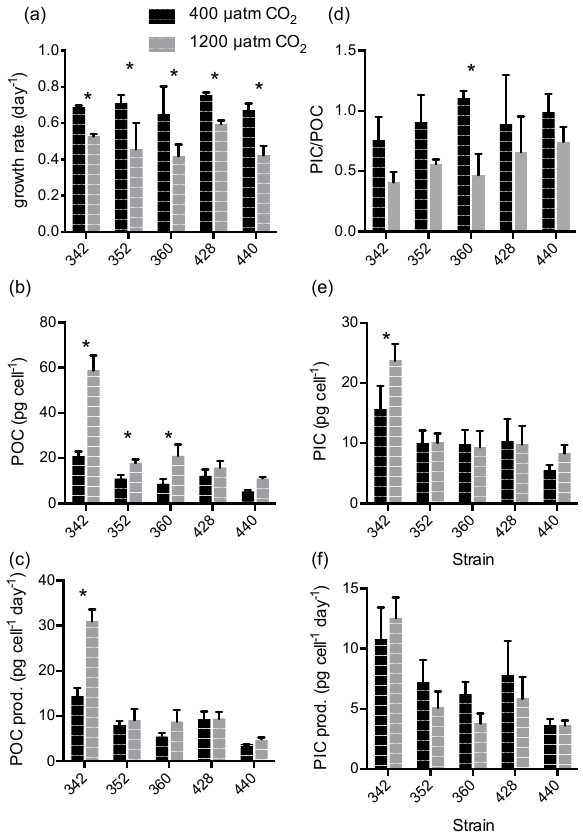
Figure 5. Growth rates (a) , POC quotas (b) , POC production rates (c) , PIC / POC (d) , PIC quotas (e) , and PIC production rates (f) of E. huxleyi strains in response to 400µatm (black bars) and 1200µatm (grey bars) CO 2 treatments. See Table 3 for global two-way ANOVA results. The ∗ indicates a significant difference ( p < 0 . 05) in pairwise comparison between the two CO 2 treatments for a given strain, as judged by Sidak post hoc testing with correc- tion for multiple